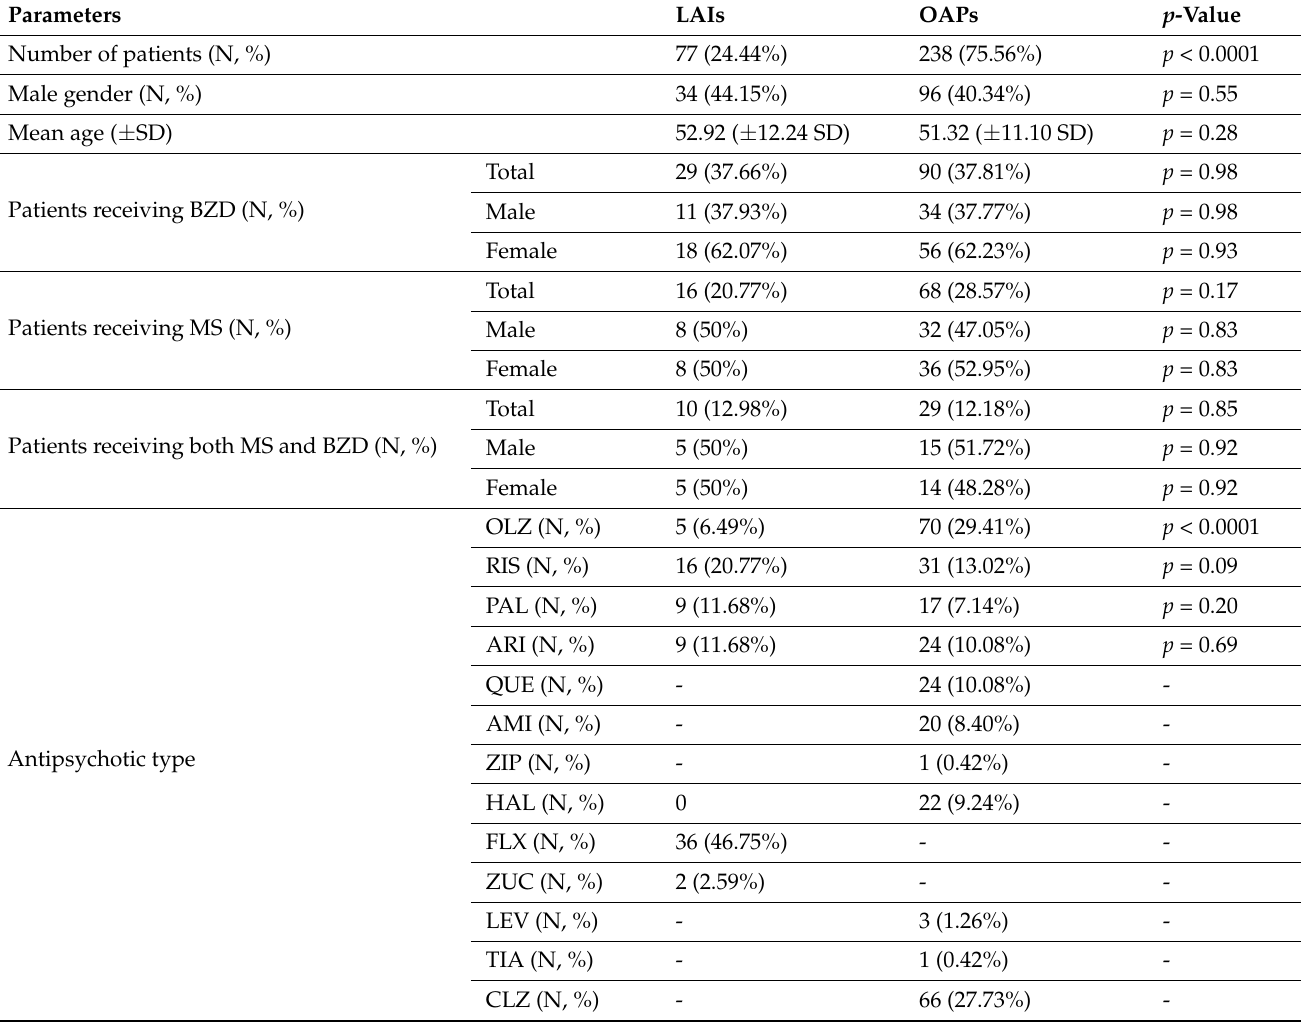
Table 1. Demographics and treatment characteristics of the study